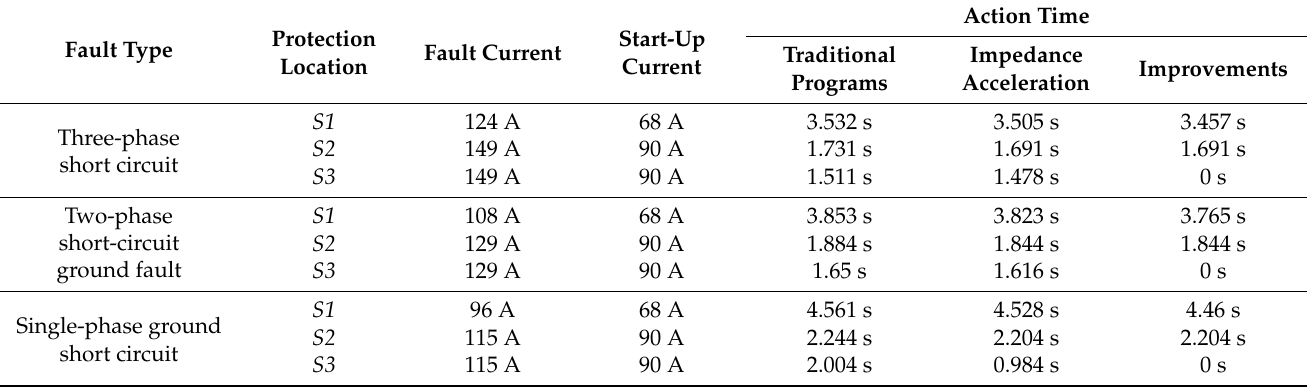
Table 5. Operating time of different protection schemes in the case of line CD via 100 Ω ground resistance fault.